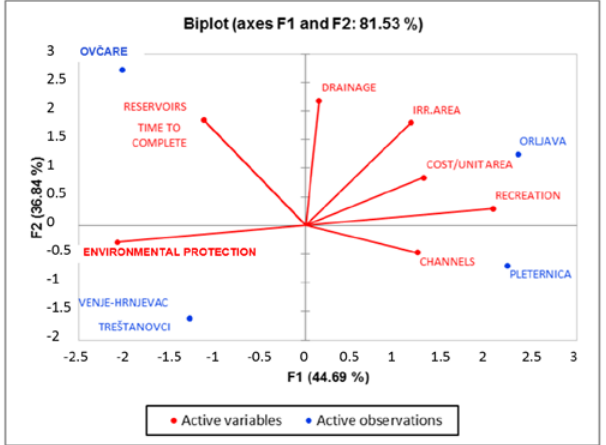
Figure 12. Biplot of key factors and observed locations.